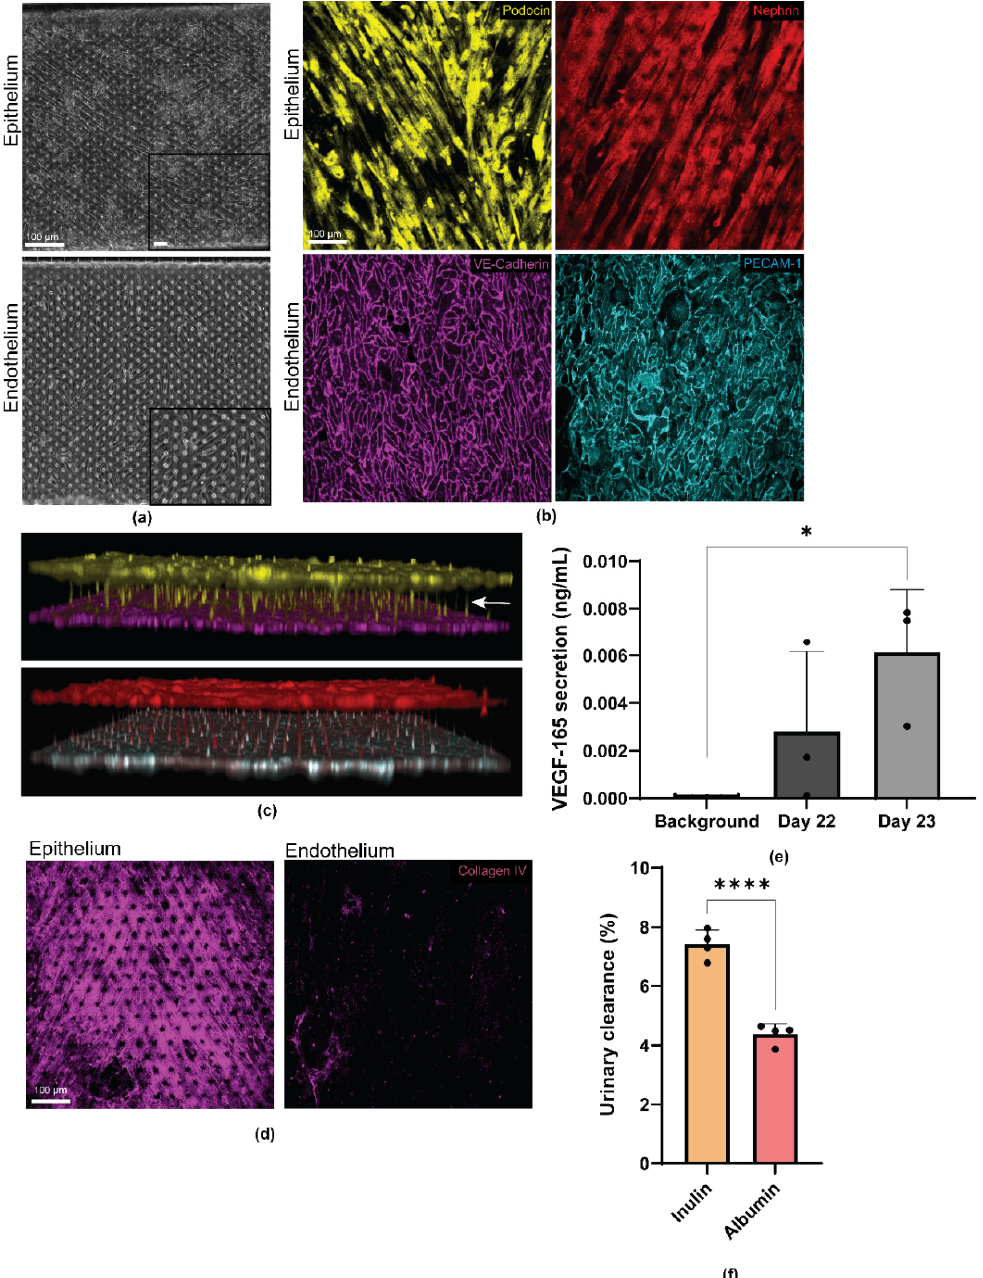
Figure 2. Human iPS cell derived glomerular epithelial (podocytes) and endothelial cells express mature cell markers and form foot processes extending from podocytes to endothelial cells, indicating intercellular cross talk. ( a ) Bright field images of the glomerular epithelia in the urinary channel and endothelium in the capillary channel. Scale bar 100 µm; ( b ) Representative confocal microscopy images of the podocytes and endothelial cells stained for Podocin (yellow), Nephrin (red), VE Cadherin (magenta), and PECAM-1 (cyan), respectively. Scale bar 100 µm; ( c ) Three-dimensional reconstruction of the epithelial to endothelial tissue–tissue interaction formed by Podocin positive (yellow) podocytes and VE Cadherin positive (magenta) endothelial cells; and Nephrin positive (red) podocytes and PECAM-1 positive (cyan) endothelial cells at the interface; arrow indicates cellular crosstalk through physical proximity; ( d ) Representative confocal microscopy images of collagen IV positive (magenta) glomerular epithelia in the urinary channel and endothelium in the capillary channel. Scale bar 100 µm; ( e ) Quantification of the VEGF-165 secretion by the mature podocytes. Background indicates culture medium not exposed to podocytes. n = 3. * p = 0.0169 and ( f ) Quantification of percent inulin and albumin clearance from the urinary channel of the glomerulus chip. n = 4. **** p = 0.0001.